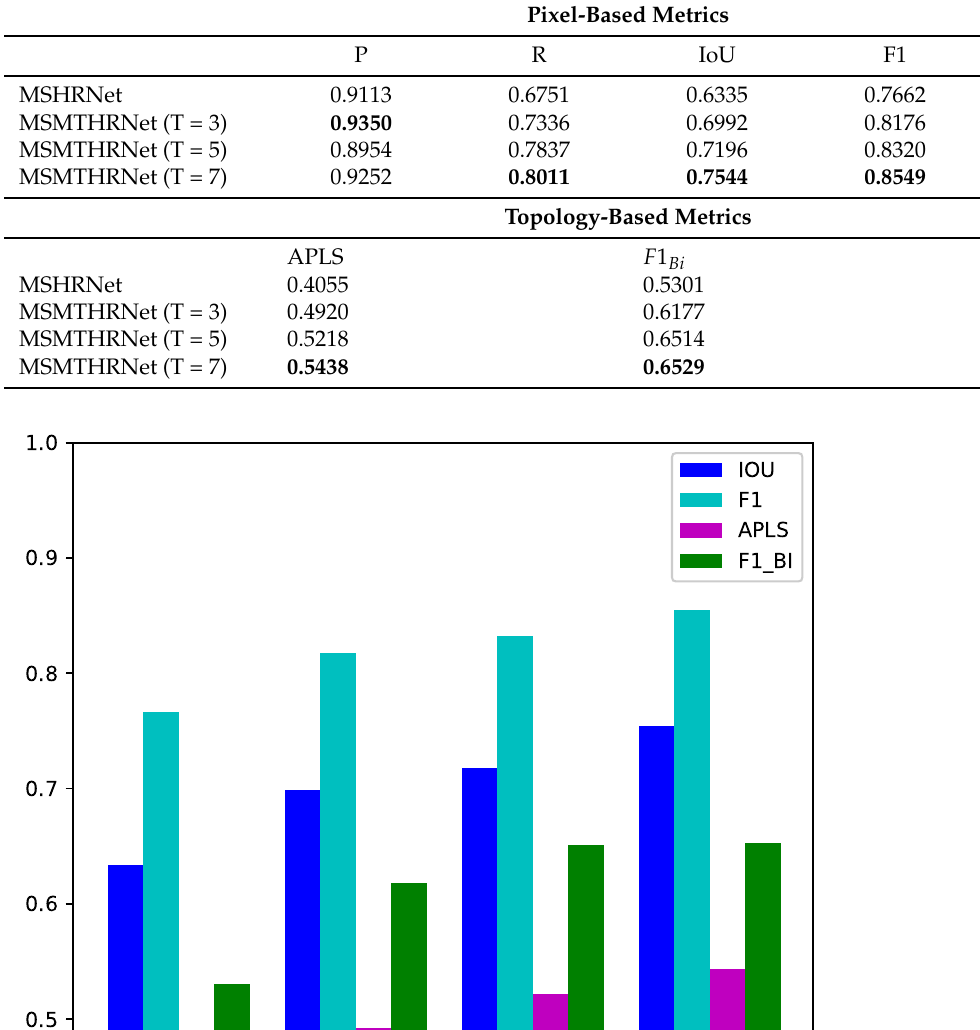
Table 3. Comparative quantitative Evaluation Among Different Methods for Road Detection on our dataset. It should be noted that the results are the average performance of all images in the test set. A higher value indicates a better performance. With the best results marked in bold.